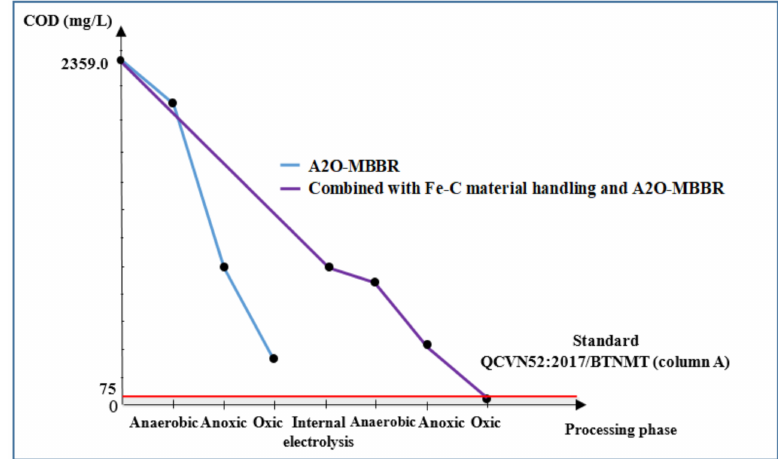
Figure 9. COD treatment e ffi ciency (mg / L) via A2O-MBBR system and through treatment of Fe-C material combined with A2O-MBBR system.